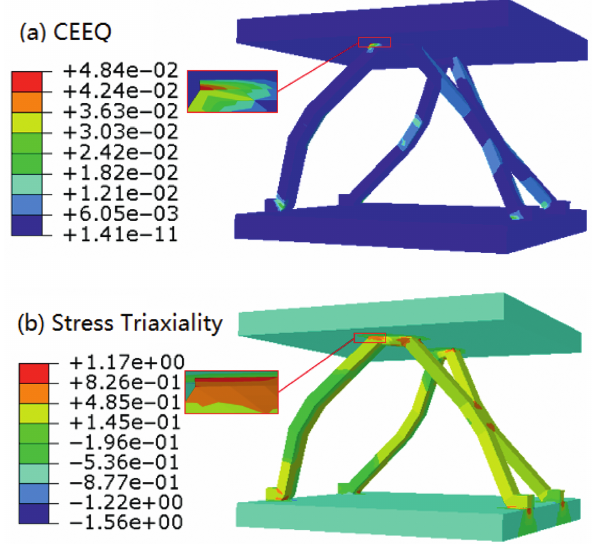
Figure 5: Contours of CEEQ (a) and stress triaxiality (b) at tensile load.